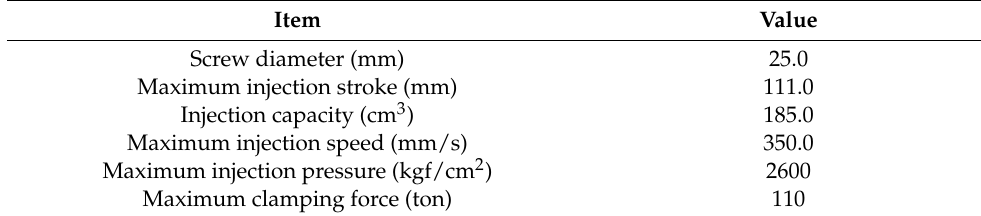
Figure 5. Photographs of the ( a ) injection molding machine and ( b ) mold used. Table 3. Specification of injection molding machine (LGE110).